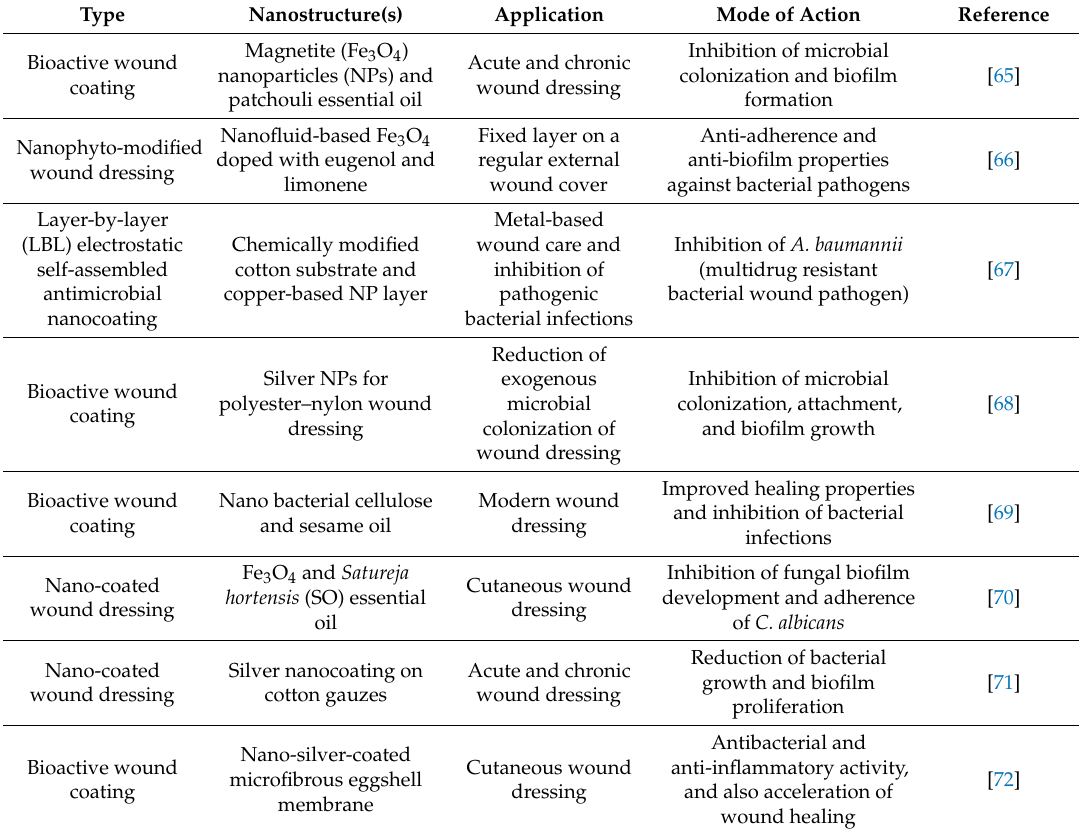
Table 2. Nanostructured coatings for